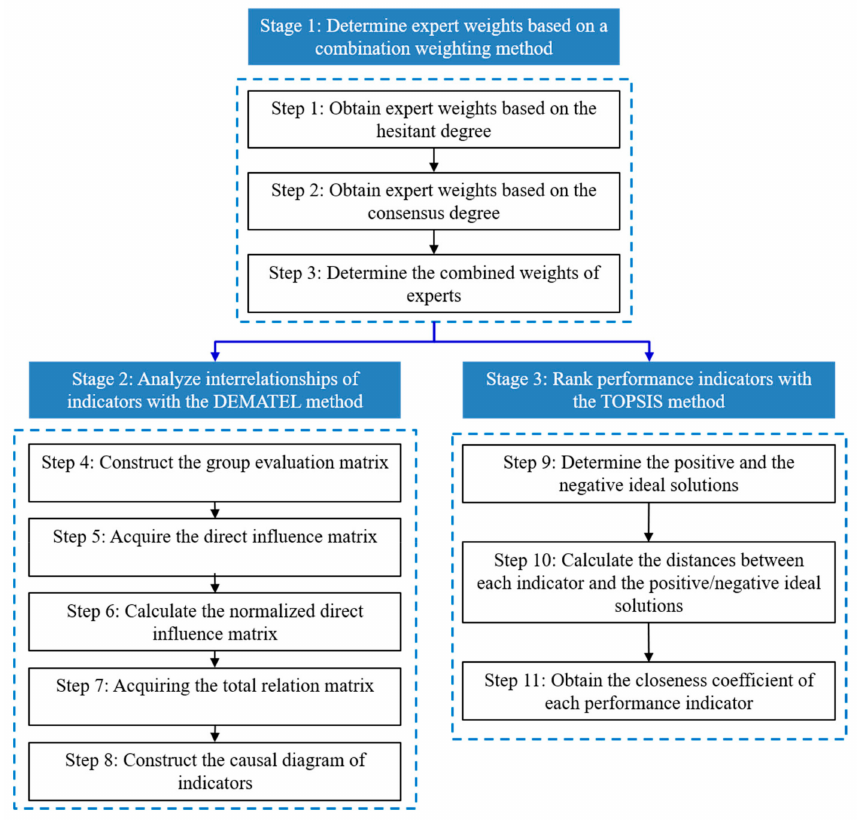
Figure 1. Flowchart of the proposed DHHFL–DEMATEL